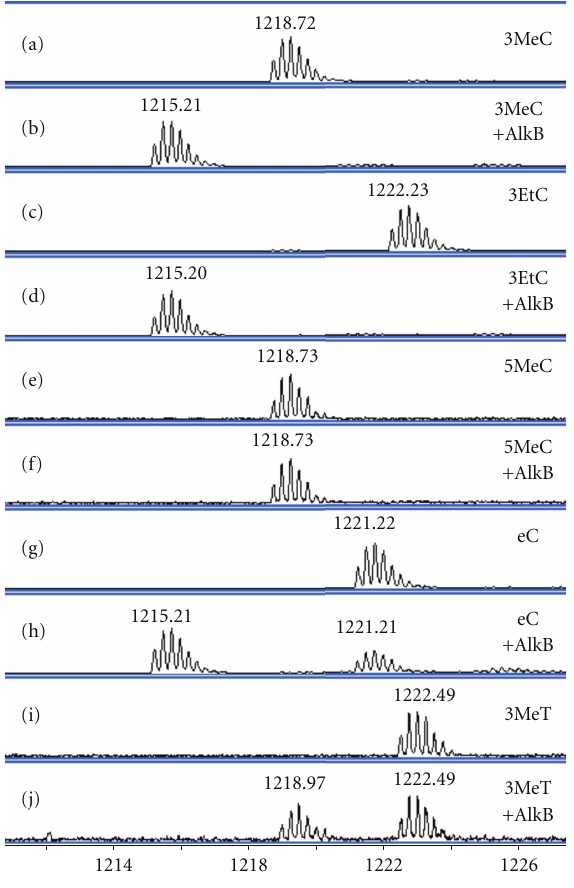
Figure 5: ESI-TOF analysis of 16 mer reactants and products from the in vitro incubation reactions of alkylated lesions and AlkB protein. Data represent the − 4 charge envelopes; multiple ion mass peaks associated with each envelope reflect mostly the number of 13 C atoms in each − 4 charged packet. The monoisotopic peak (all 12 C, 14 N, etc.) value is labeled above each peak envelope. (a) 3MeC; (b) 3MeC + AlkB; (c) 3EtC; (d) 3EtC + AlkB; (e) 5MeC; (f) 5MeC + AlkB; (g) eC; (h) eC + AlkB; (i) 3MeT; (j) 3MeT +